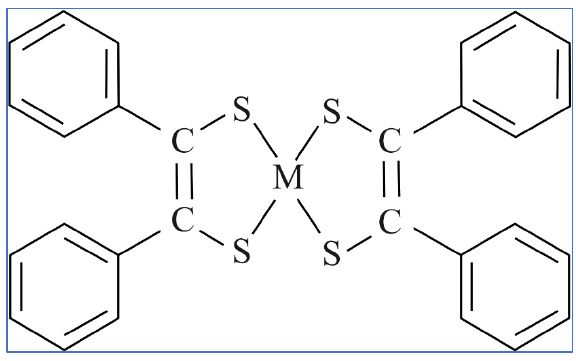
Figure 13. Structure of the dithiolene metal complex dye.